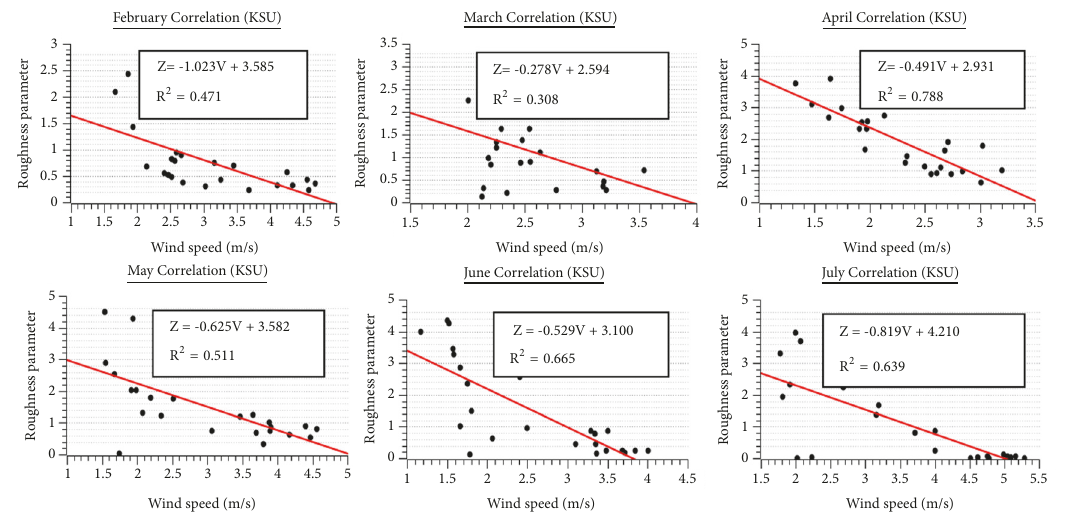
Figure 11: Correlation of wind speeds and roughness parameter for Kisii University station.